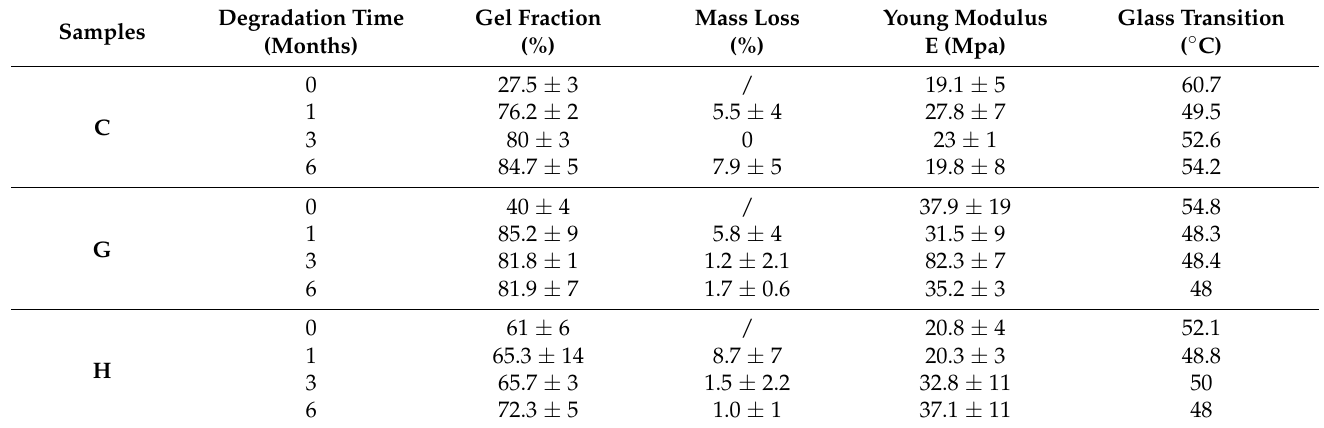
Table 1. Scaffold properties during 6 months of degradation in